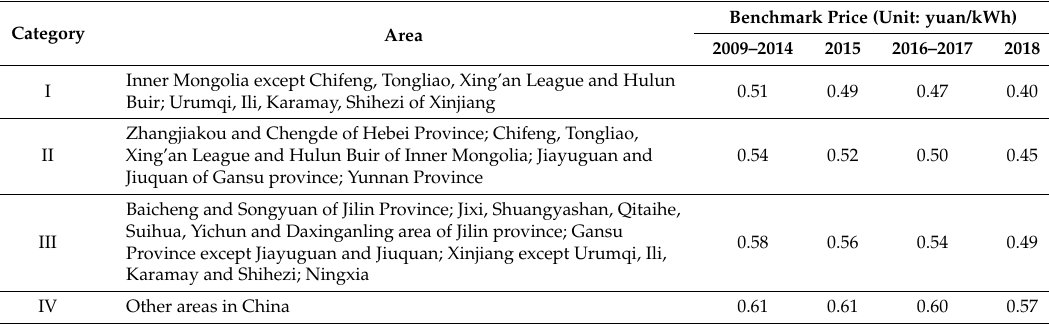
Table 2. Benchmark price of onshore wind power in China during